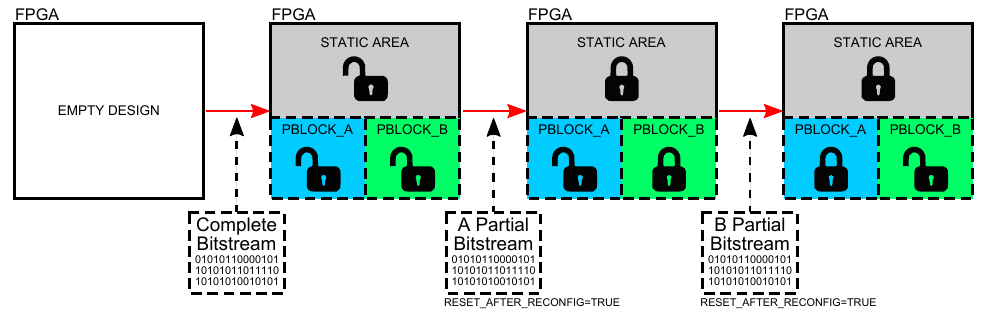
Figure 4. Effect of the RESET_AFTER_RECONFIG=TRUE property in FPGA